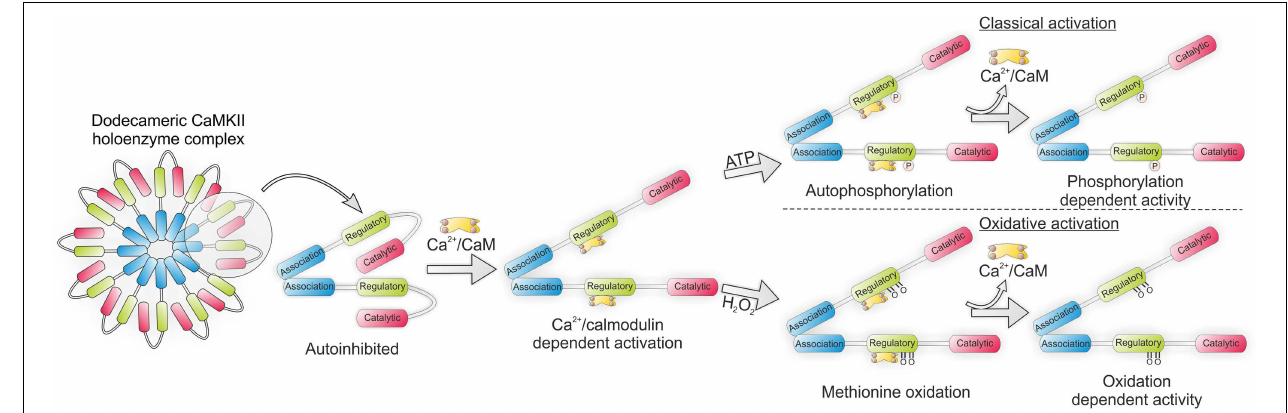
FIGURE 3 | CaMKII holoenzyme structure showing classical activation by autophosphorylation and oxidative activation by methionine sulfoxination. In each instance binding of Ca 2 + /calmodulin (Ca-CaM) is necessary to first expose the regulatory domain.